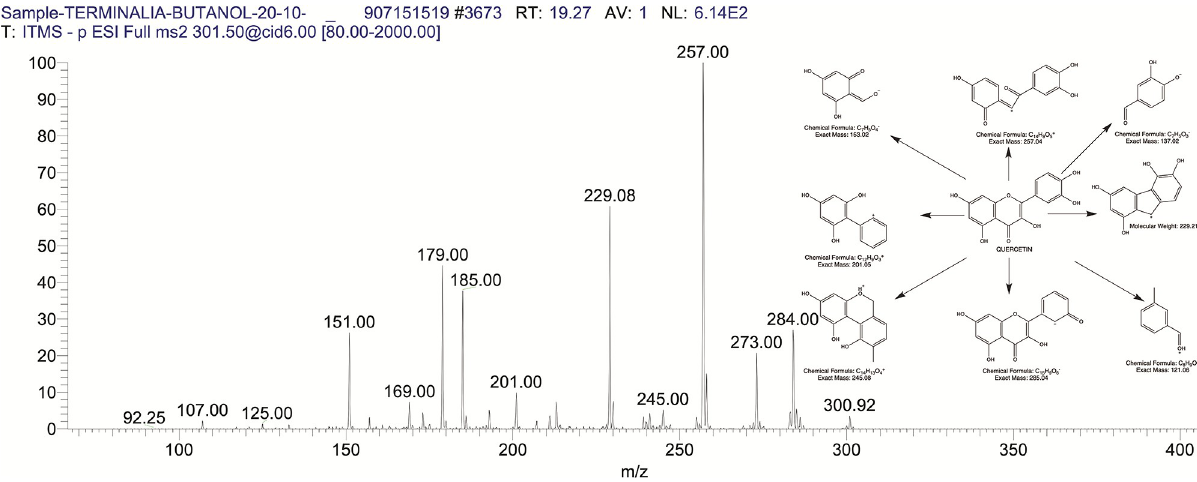
Fig 12. The mass spectrum of quercetin and its fragmentation